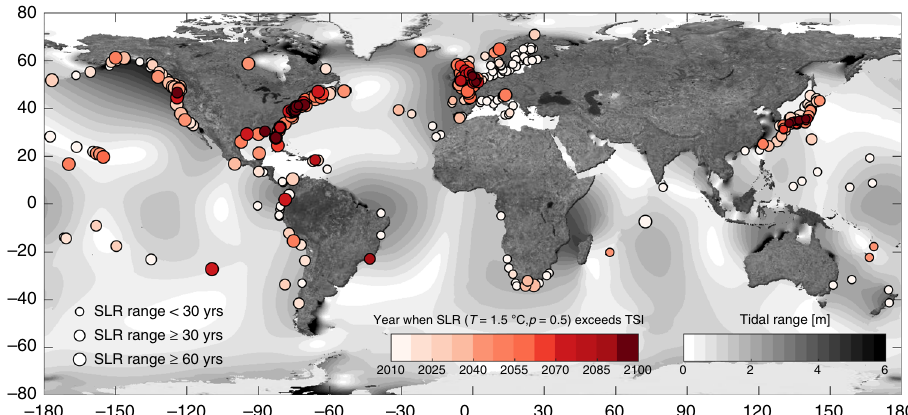
Fig. 4 Global map of sea level rise vs. non-linear effects. For all sites, the years when sea level rise (assuming a warming of + 1.5 °C by 2100 in global temperatures at the median probability) exceeds non-linear effects (based on the 99th percentile) are shown. The marker size indicates the range (max.- min.) of possible outcomes if other than the median probability sea level rise (i.e., the 5 to 95% probability) projections are